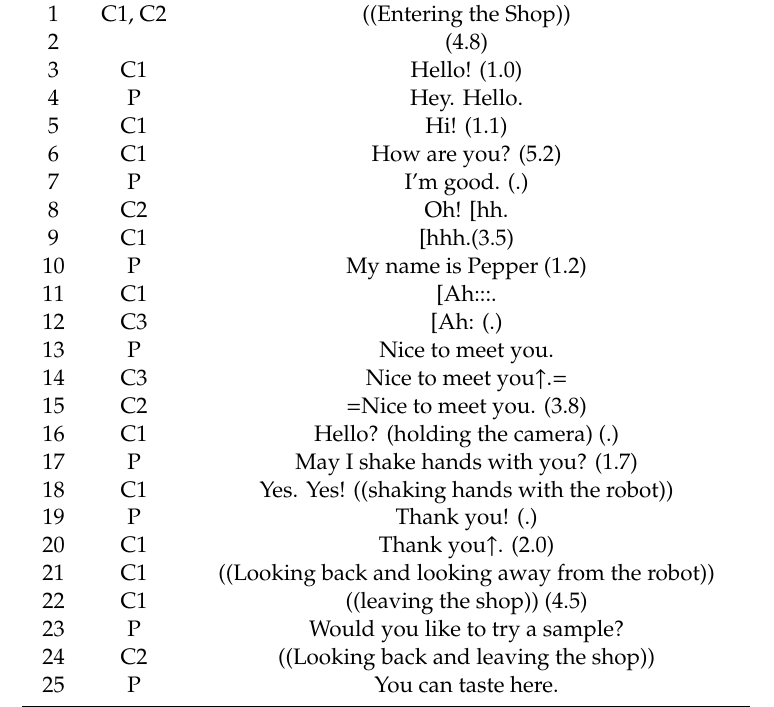
Table 11. Conversation with a group that ignored the robot’s suggestion to taste a sample without the state-transition model (17April